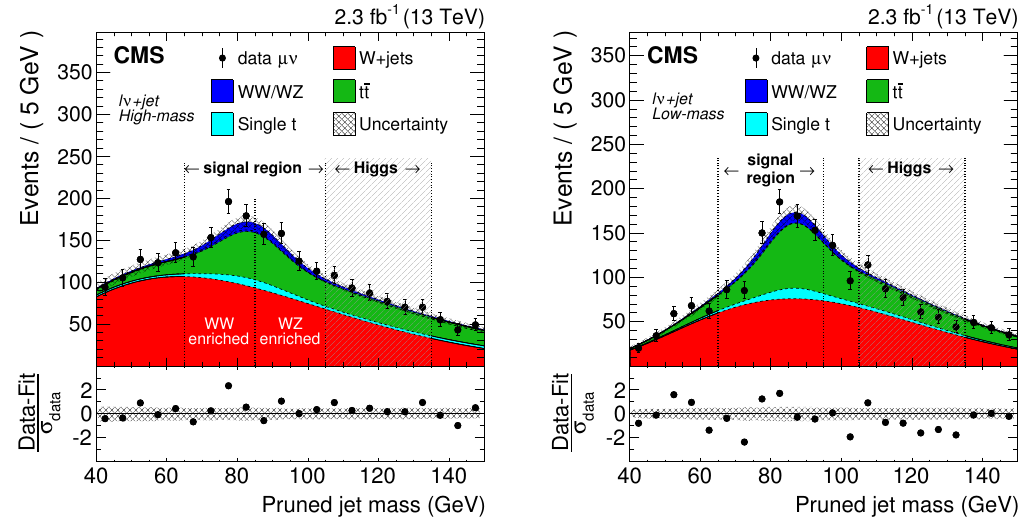
Figure 3 . Distributions of the pruned jet mass m jet in the ‘(cid:23) +jet high-mass (left) and low-mass (right) analyses in the muon channel. All selections are applied except the requirement on m jet signal window. Data are shown as black points. The signal regions and m jet categories of the analyses are indicated by the vertical dotted lines. The shaded m jet region 105{135 GeV is not used in these analyses. In the lower panel of each plot, the bin-by-bin (cid:12)t residuals, ( N data (cid:0) N (cid:12)t ) =(cid:27) data , are shown together with the uncertainty band of the (cid:12)t normalized by the statistical uncertainty of data points, (cid:27) data